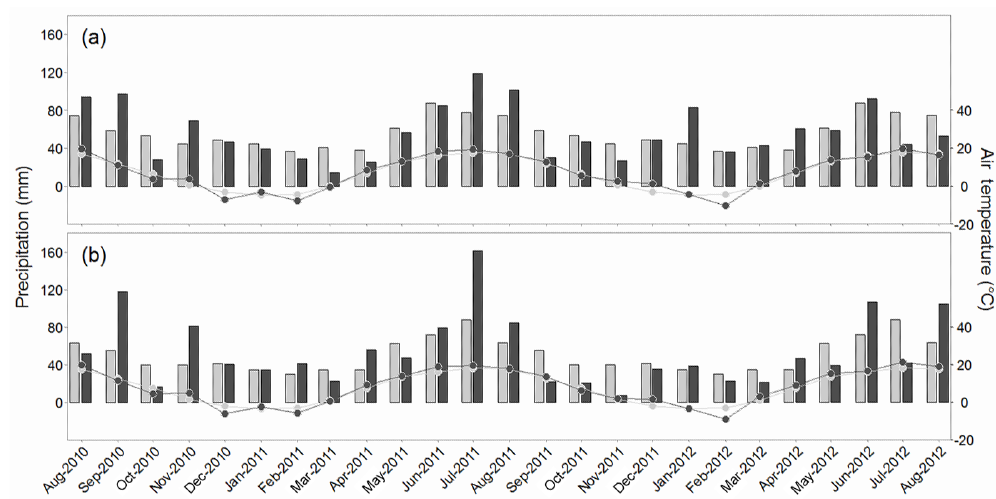
Figure 2. Cumulative monthly precipitation (bars) and average monthly air temperatures (dots) for Barcianicha (a) and Giel’ˇcyka˘u Kašyl’ (b) . Actual temperatures (black) were measured in (a) Višnieva, 5.6kmNW of Barcianicha, and (b) Z’dzitava, 6.3km NE of Giel’ˇcyka˘u Kašyl’. Actual precipitation data (black) and 30 year averages (1979–2008) of temperatures and precipitation (grey) are from meteorological stations of “Gidrometcentr” in (a) Valožyn, 15 km E of Barcianicha, and (b) Pružany, 54km WNW of Giel’ˇcyka˘u Kašyl’.